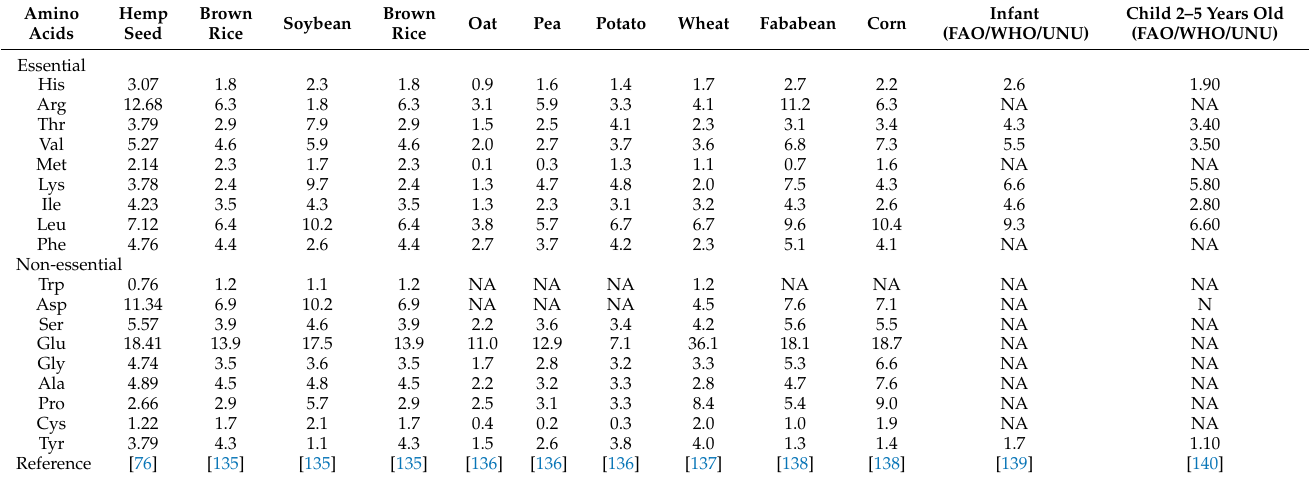
Table 4. Amino acid compositions of dietary protein and the FAO/WHO/UNU suggested